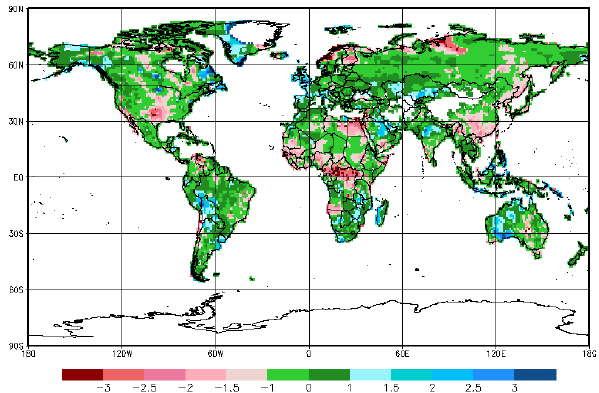
Figure 10. The GPCC-DI with 1-month aggregation interval for January 2014. The color scale is the same as in Fig. 3.